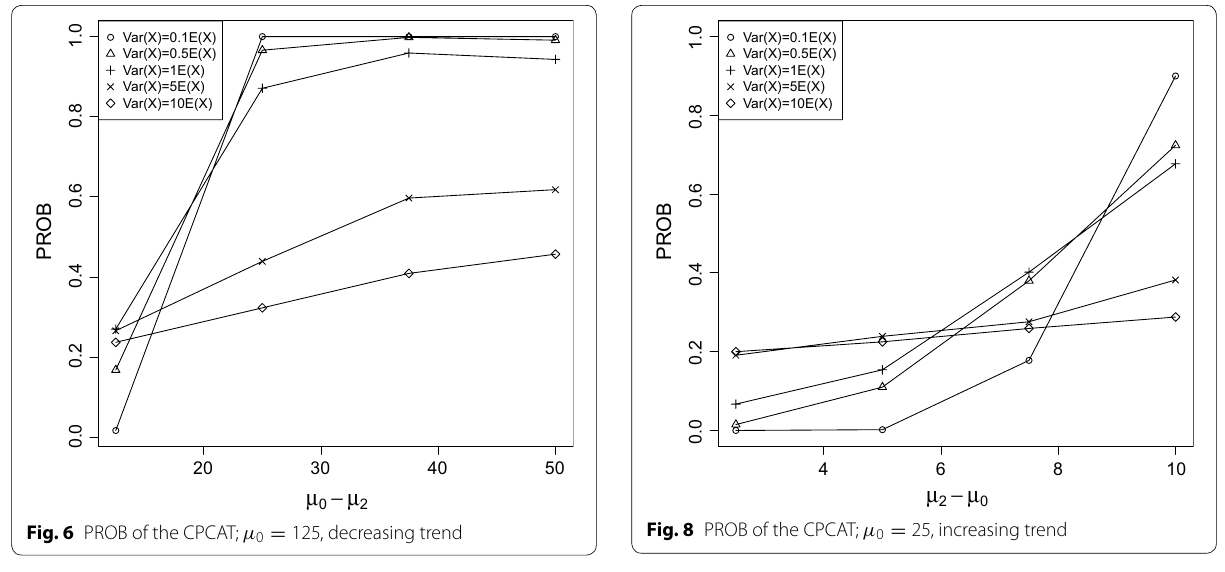
Fig. 6 PROB of the CPCAT; µ 0 = 125 , decreasing trend